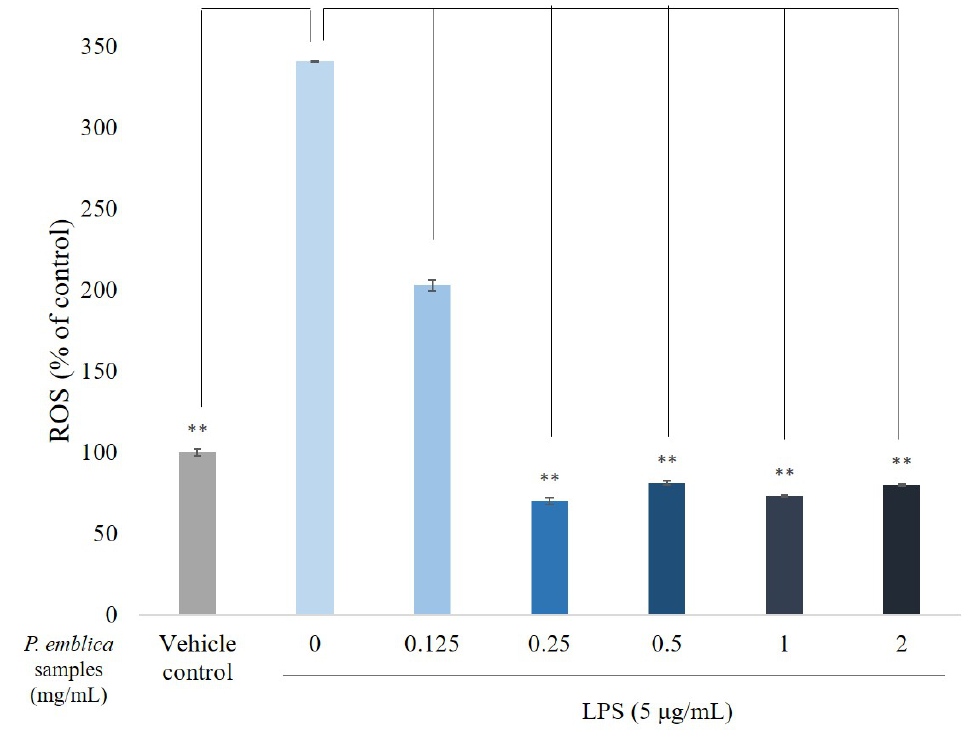
Figure 2. The reactive oxygen species (ROS) percentage measured by a flow cytometry. RAW 264.7 cells were pretreated with P. emblica samples (0.125–2 mg / mL) for 1 h, and then stimulated with LPS (5 µ g / mL) for 6 h. The data represented mean ± S.D of three independent experiments performed. *p < 0.05, **p < 0.01.